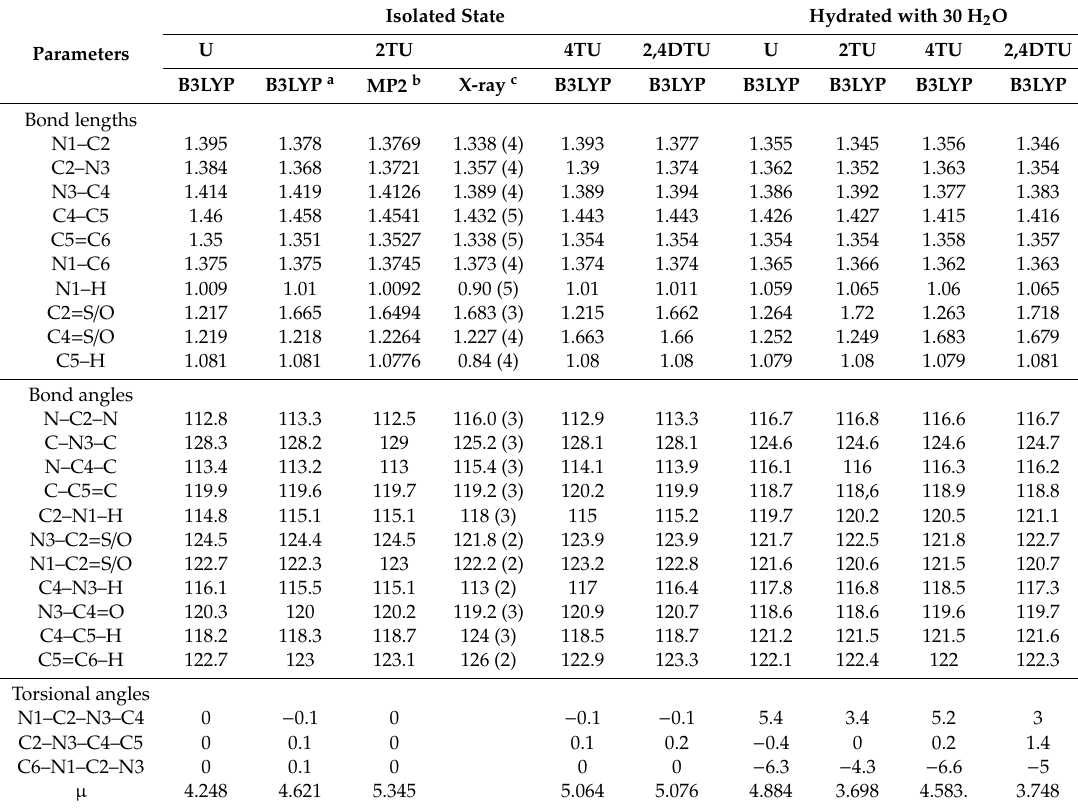
Figure 1. Atomic numbering for 2-thiouracil (2TU), 4-thiouracil (4TU) and 2,4-dithiouracil (2,4DTU) molecules. Table 1. Geometrical parameters, bond lengths (in Å) and angles (in degrees) of uracil (U), 2-thiouracil (2TU), 4-thiouracil (4TU) and 2,4-dithiouracil (2,4DTU) by B3LYP and MP2 methods with the 6-31G(d,p) basis set in the monomer form (isolated state) and under hydration in the cluster with 30 water molecules, and experimental one of 2TU in the solid state by X-ray.